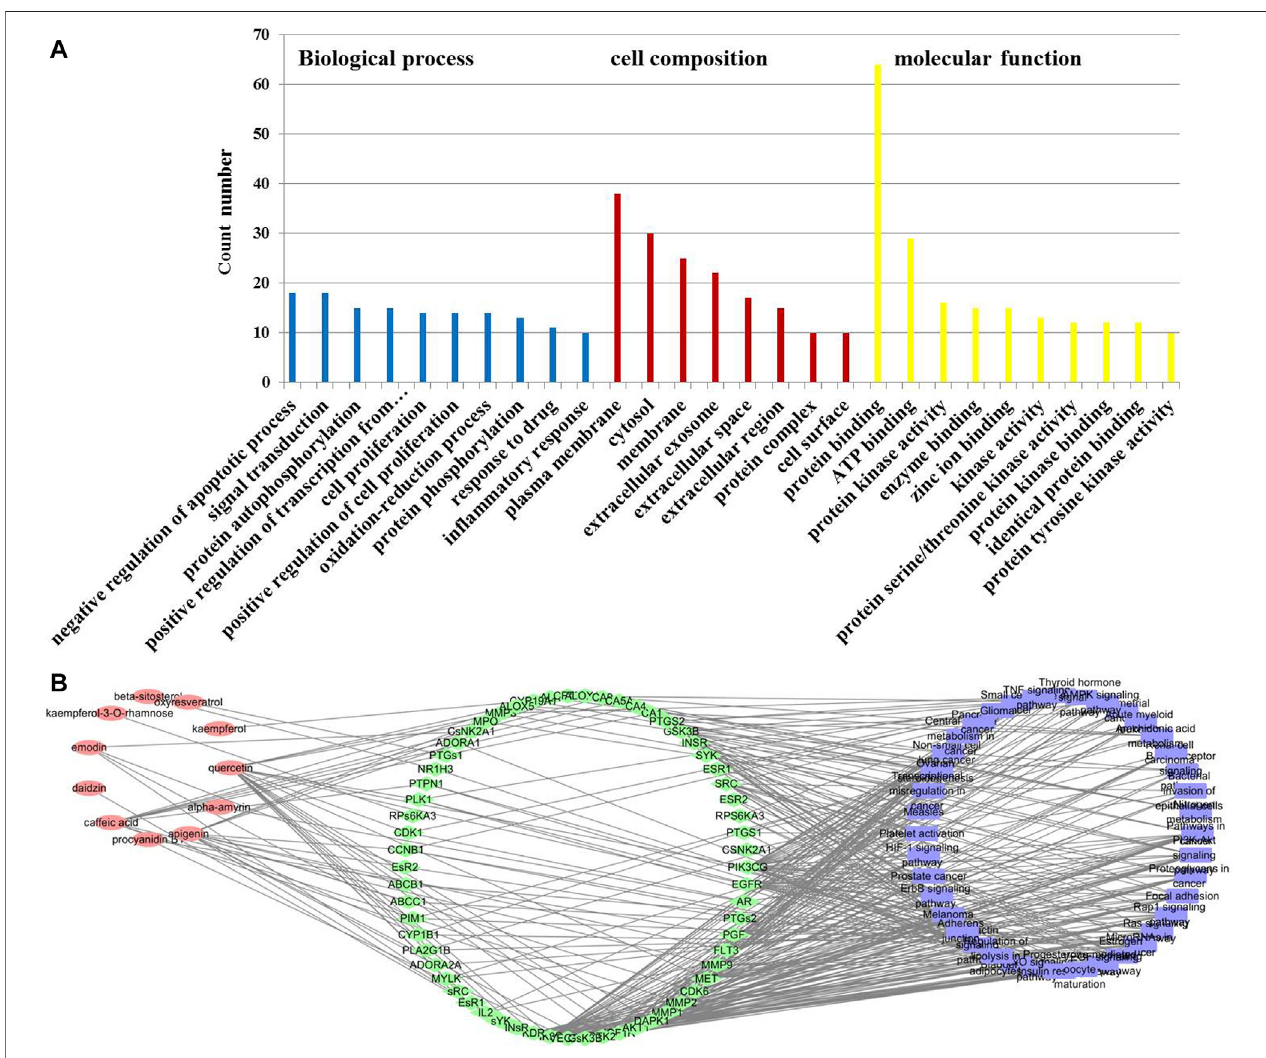
FIGURE 3 | The potential target – pneumonia target network and analysis of T. hemsleyanum leaf. (A) GO enrichment analysis for 80 drug – disease targets. (B) The active component – target – KEGG pathway of T. hemsleyanum leaf. Green indicates drug – disease intersection proteins, red indicates active compounds, and blue indicates the pathway.